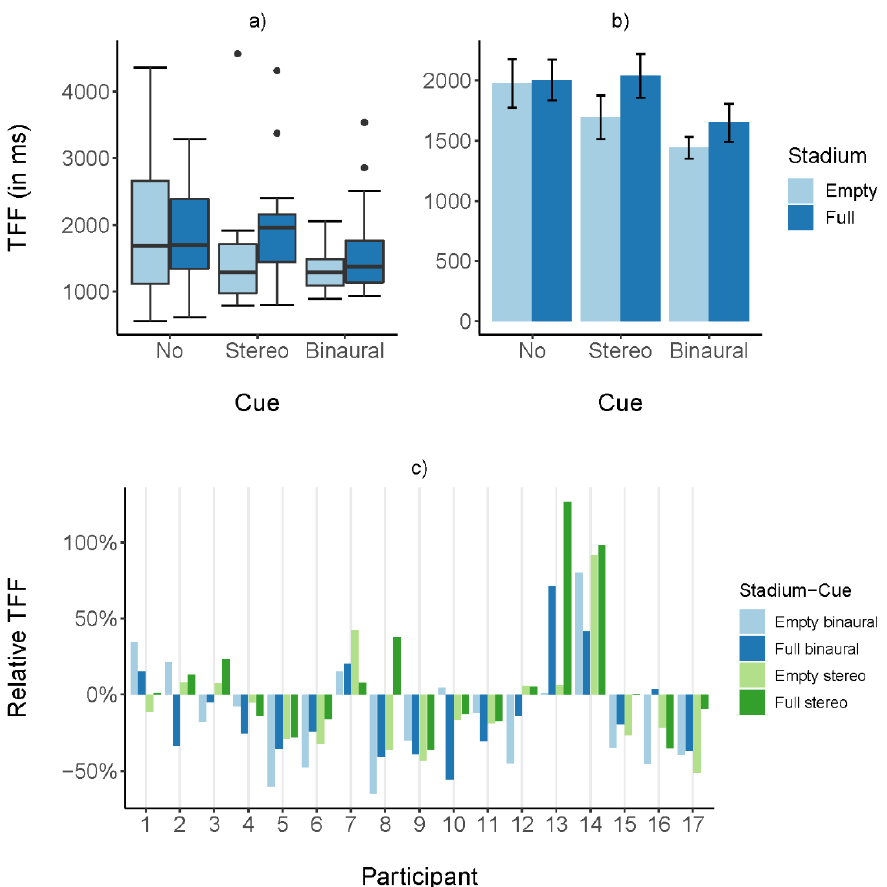
Figure 2. ( a ) Boxplot with median TFFs and ( b ) barplot with mean TFFs and error bars indicating standard errors of mean for 17 participants in the no cue, stereo and binaural cue conditions for the empty and full stadium conditions. ( c ) Relative changes in TFF for 17 participants in no cue, stereo and binaural cue conditions for empty and full stadium conditions. The no cue condition is interpreted as a baseline for the stereo and binaural conditions.